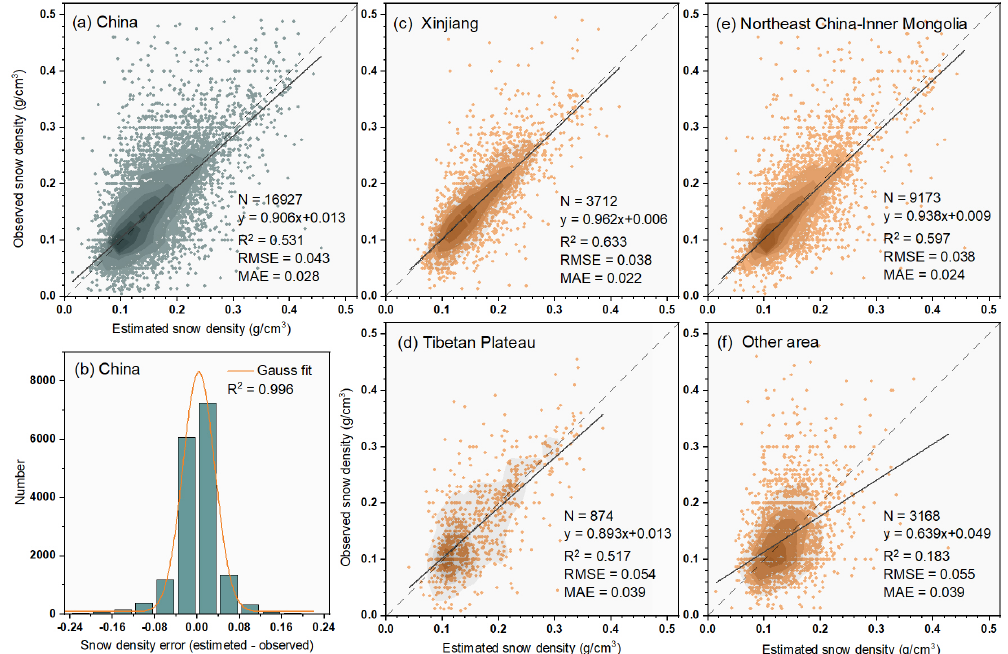
Figure 5. Accuracies of the estimated snow density in China (a) and different snow cover regions (c, d, e, f) , and the histogram of the snow density errors between estimated and observed values (b)